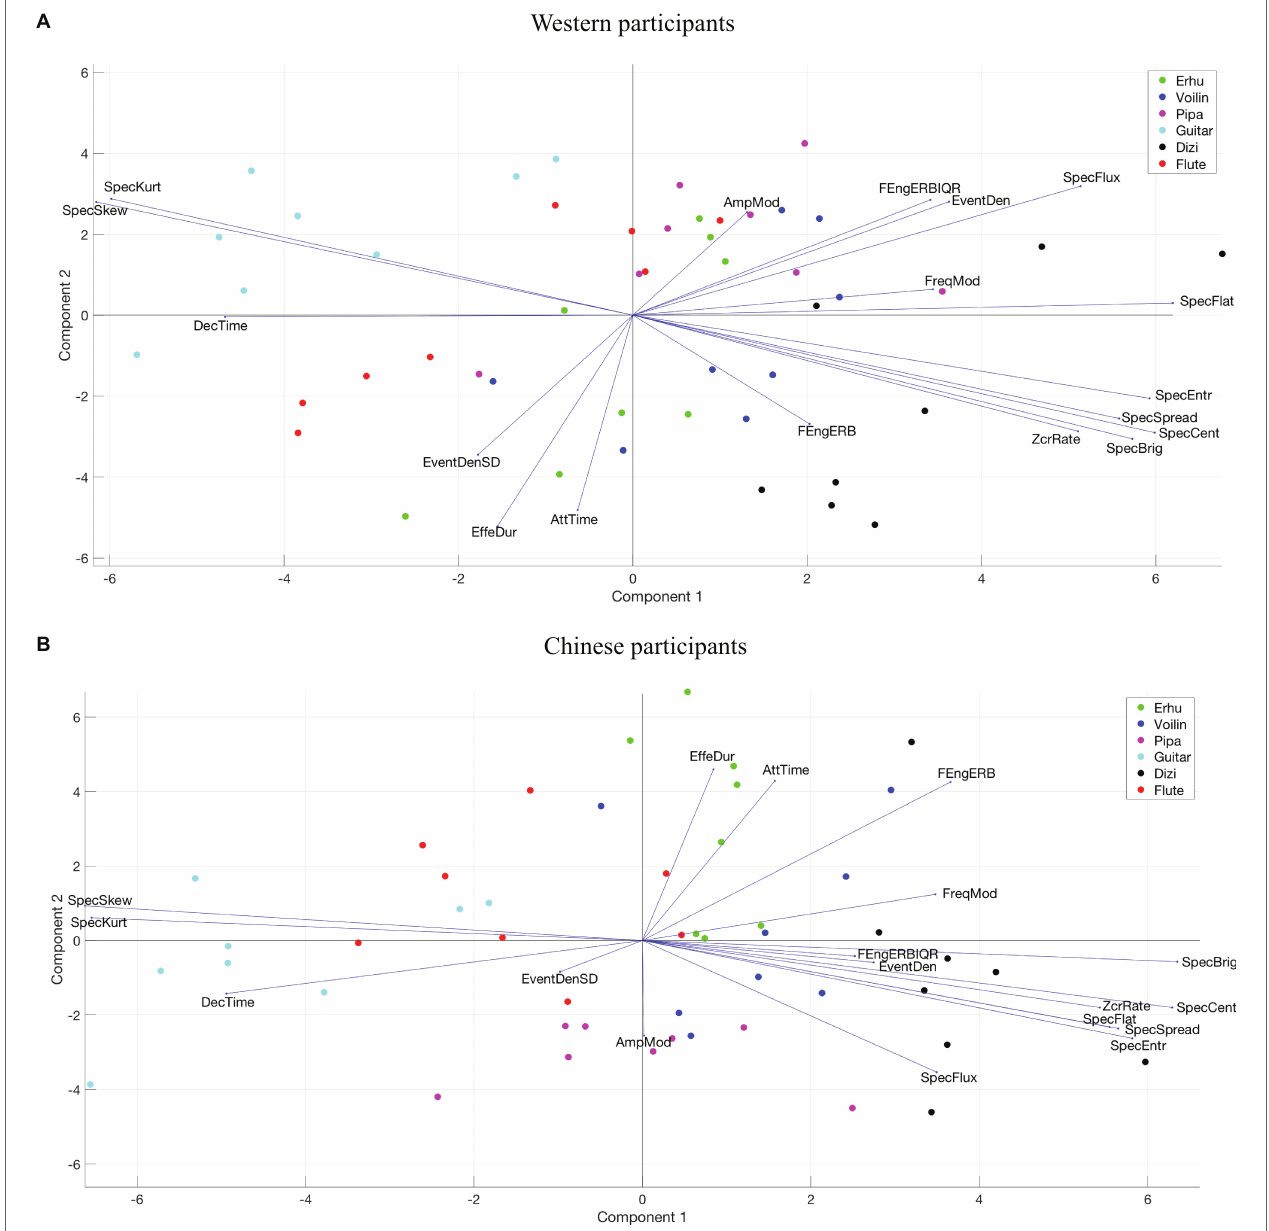
FIGURE 9 | Loadings and scores across two PCs of PLSR for tension arousal. (A) Western participants. (B) Chinese